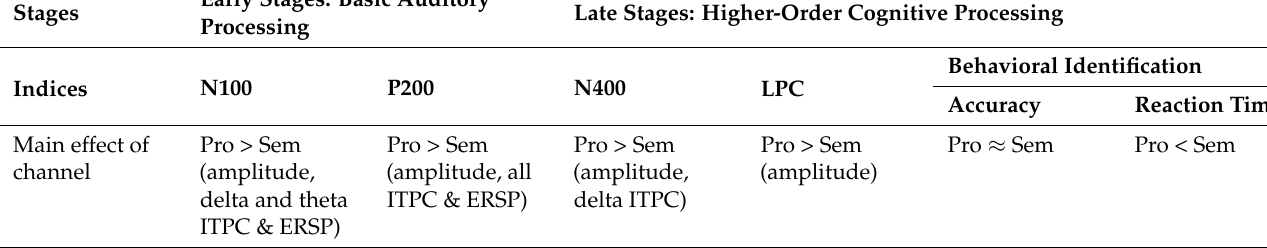
Table 5. Summary of the effects of channel, emotion and task and their interactions in each neuro- physiological and behavioral